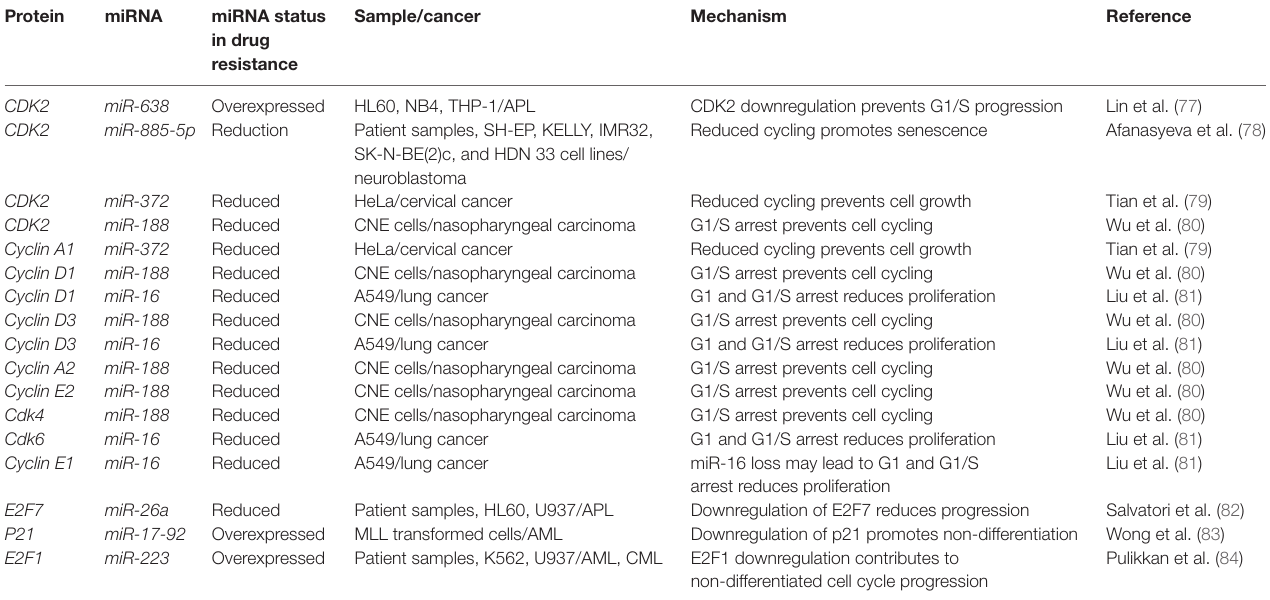
miRNAs, microRNAs; APL, acute promyelocytic leukemia; CDK, cyclin-dependent kinase; AML, acute myeloid leukemia.